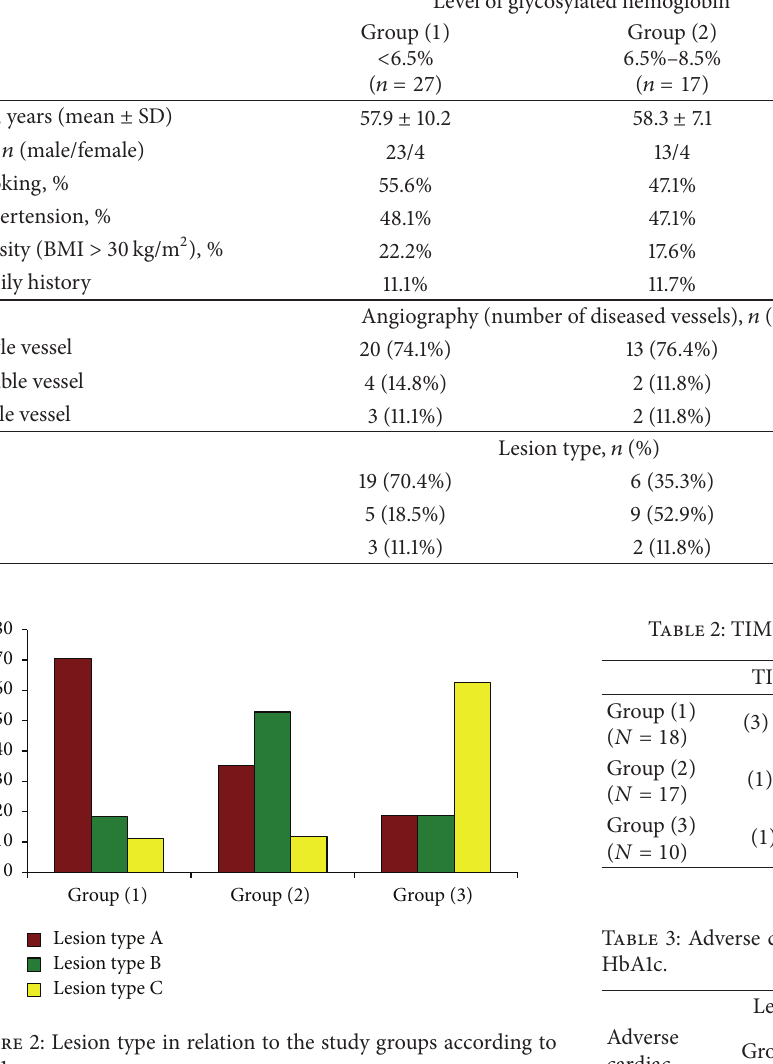
Figure 2: Lesion type in relation to the study groups according to HbA1c.